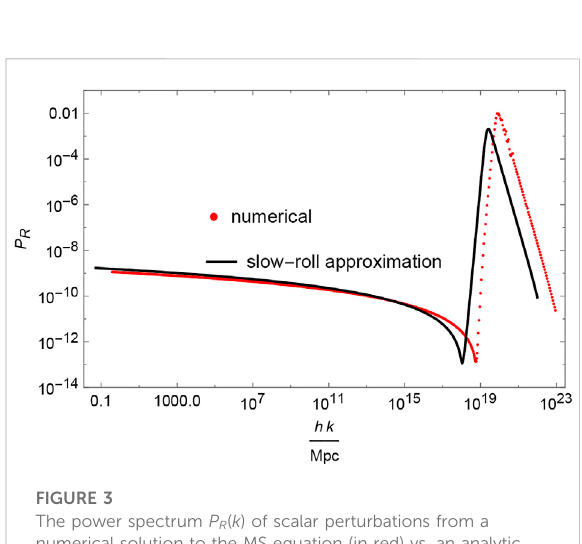
FIGURE 3 The power spectrum P R ( k ) of scalar perturbations from a numerical solution to the MS equation (in red) vs. an analytic derivation from Eq. 24 in the slow-roll approximation (in black), with the same parameters as in Figure